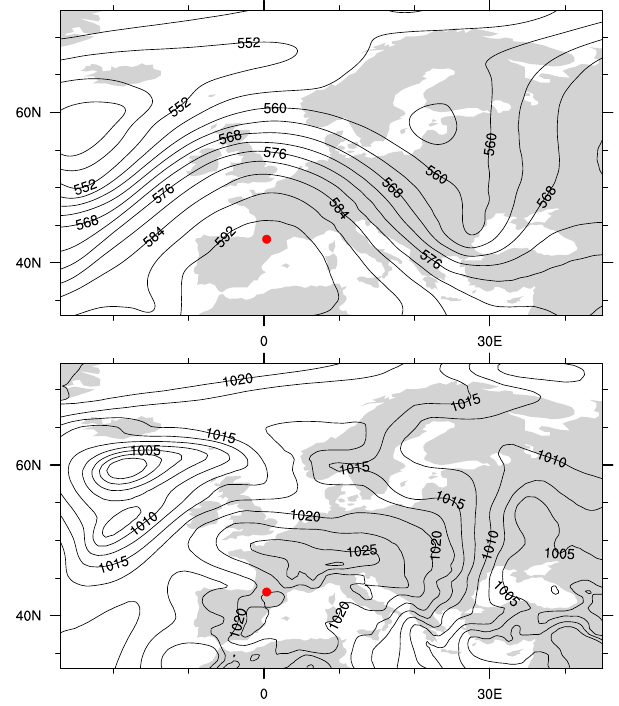
Figure 2. Geopotential height (in decameter) of the 500hPa level (upper panel) and surface pressure field (hPa) (lower panel) from the reanalysis of ECMWF at 12:00UTC of the 25 June 2011. The red dot represents the location of the BLLAST